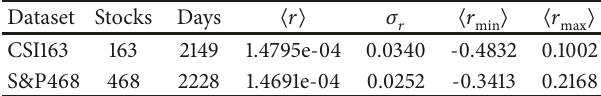
Table3:BasicinformationofCSI163andS&P468datasetsincluding the number of stocks, the number of trading days, the average log returns ⟨𝑟⟩ , and the standard deviation 𝜎 𝑟 of the log returns is presented. Compared to the US market, the Chinese market has higher fluctuations in our study period between 04/01/2007 and